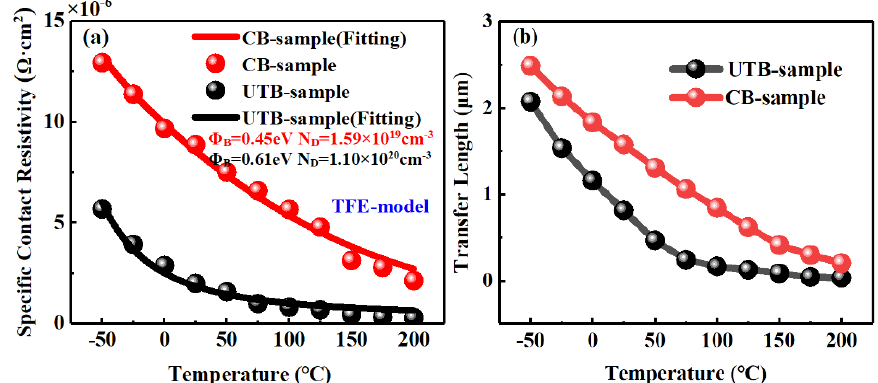
Figure 3. Measured (symbols) and modeled (lines) temperature − dependent ( a ) speci fi c contact resistivity and ( b ) transfer length of ohmic contacts to UTB − AlGaN/GaN heterostructure and CB − AlGaN/GaN heterostructure, respectively.